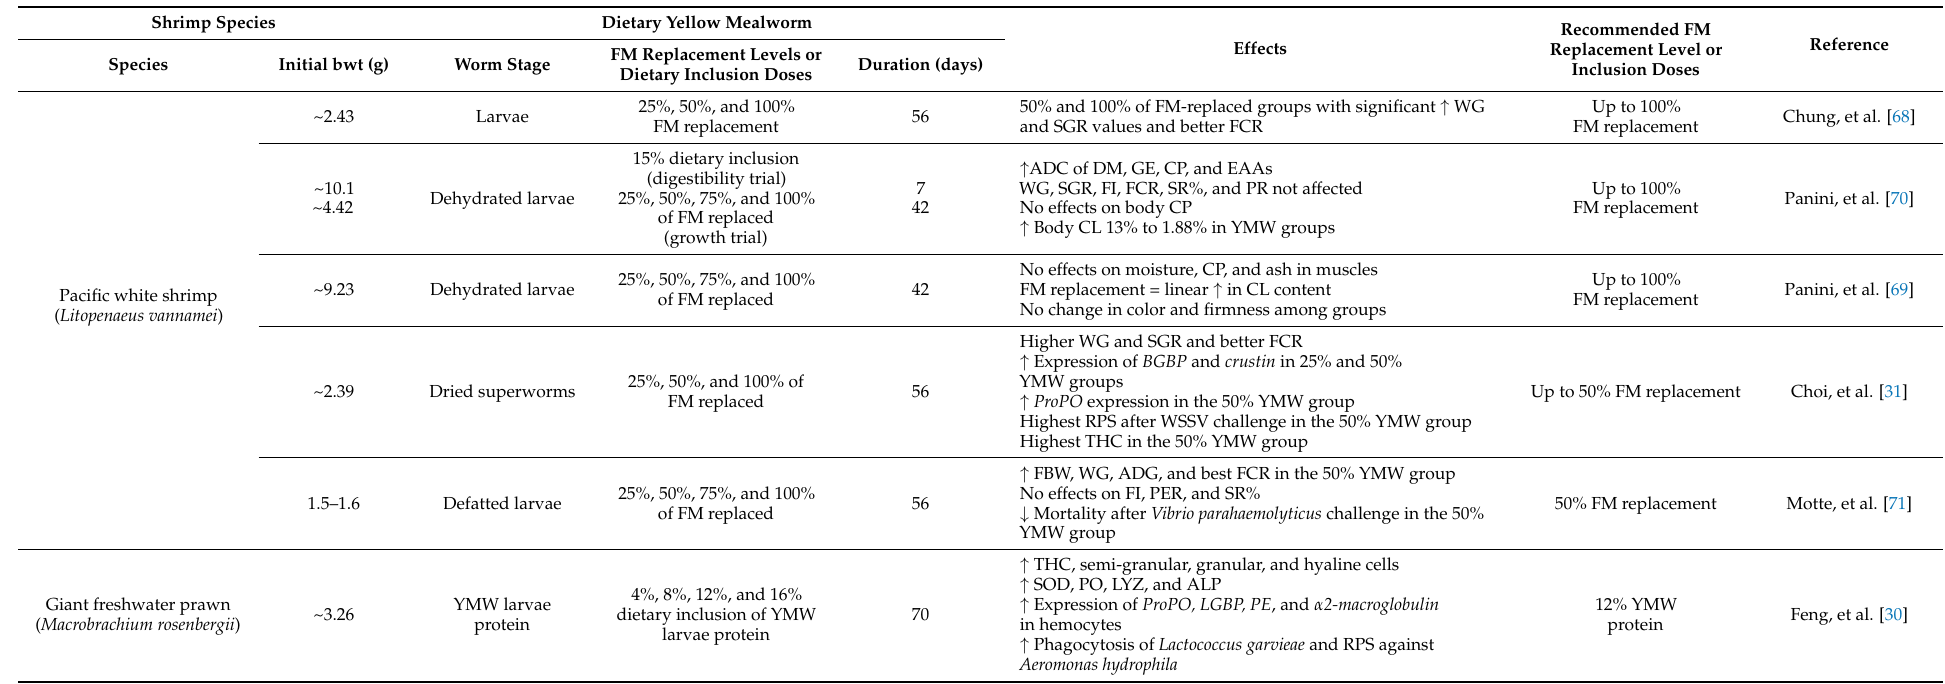
Table 8. Application and effects of using ythe ellow mealworm ( Tenebrio molitor ) in shrimp